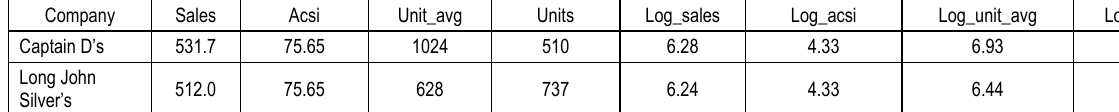
Table 13. Quick service restaurants (segment = seafood)